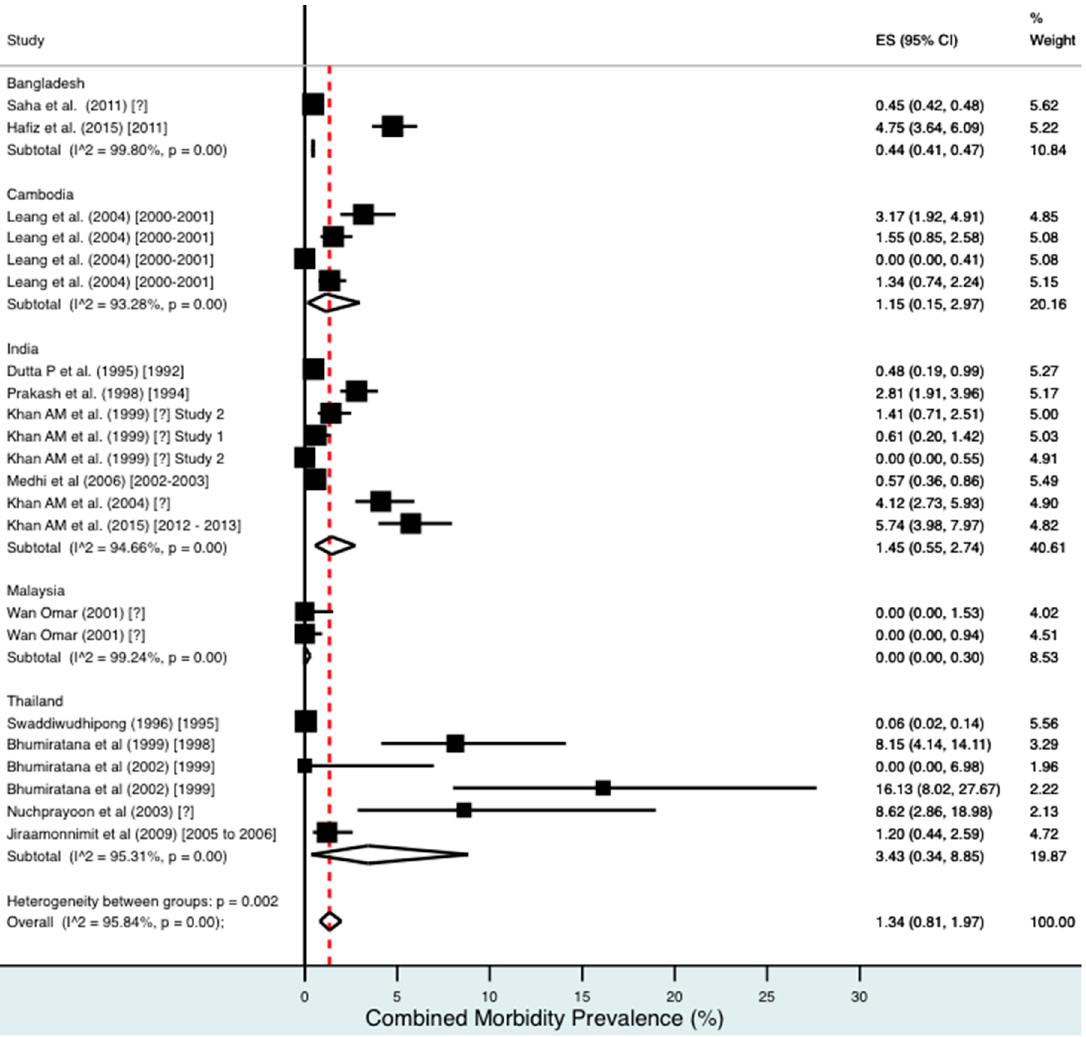
Figure 7. Percentage estimates of combined morbidity prevalence by country and year. ES: prevalence estimate. Red-dotted line: overall estimate. Diamond: sub-group estimate. Horizontal line: 95% CI.